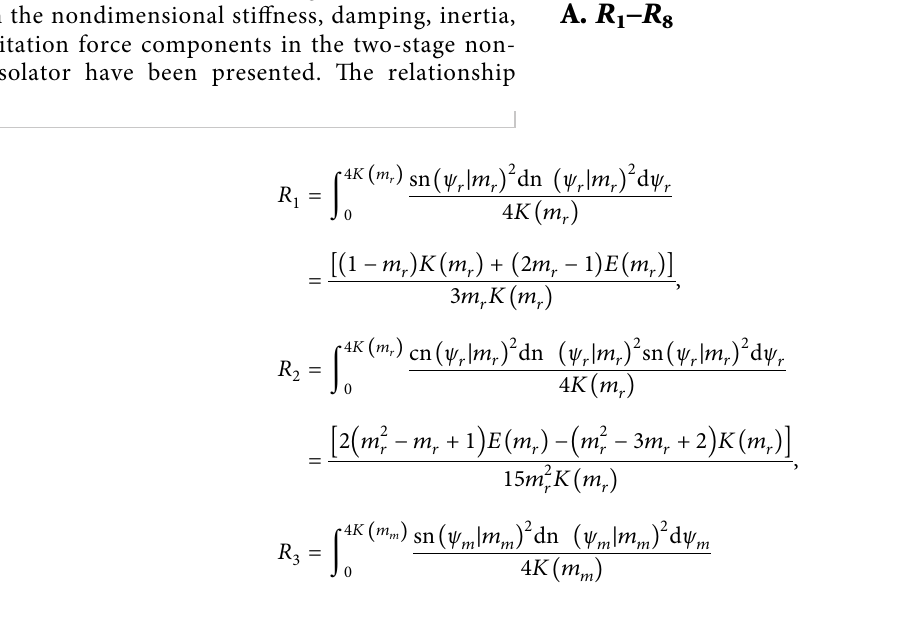
Figure 8: (a) Relative displacement transmissibility and (b) absolute displacement transmissibility when μ � 0 . 2, ζ � ζ � 0 . 1, k k � 1, k k � k k � 7/6, 􏽢 l � 0 . 7, and 􏽢 X ζ h h 2 v 2 / v 1 h 1 / v 1 h 2 / v 1 1 unstable solution by the EHBM; dot , numerical